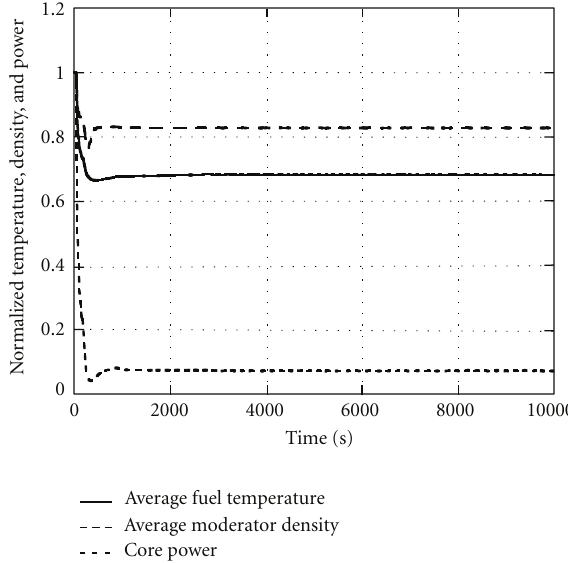
Figure 4: PWR average fuel temperature, average moderator density, and core power calculated by RELAP5